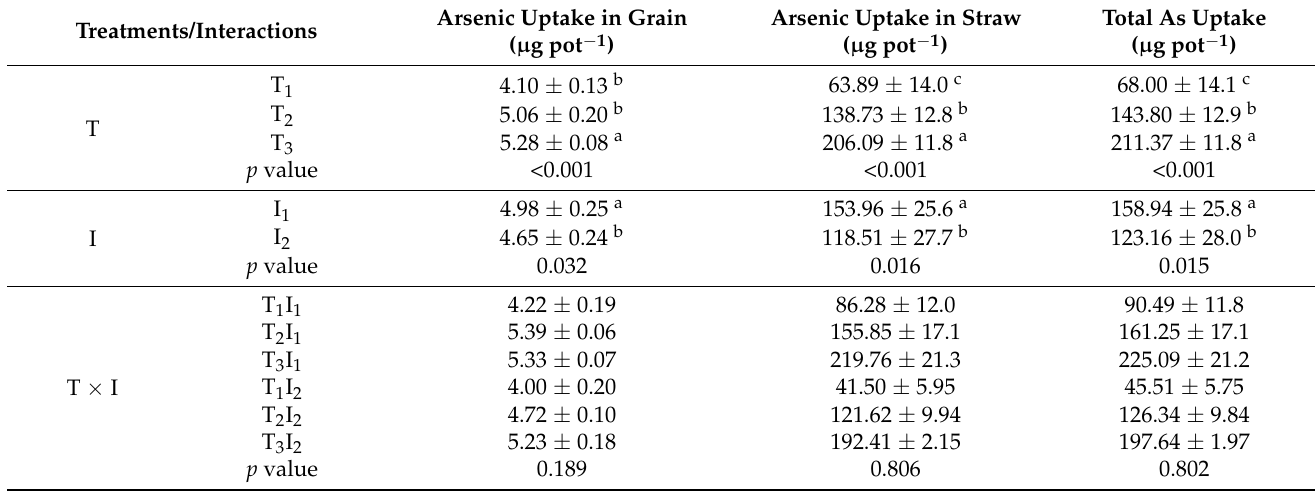
Table 4. Grain, straw, and total As uptake of rice (cv. BRRI dhan28) under different soil As concentrations and irrigation water management.